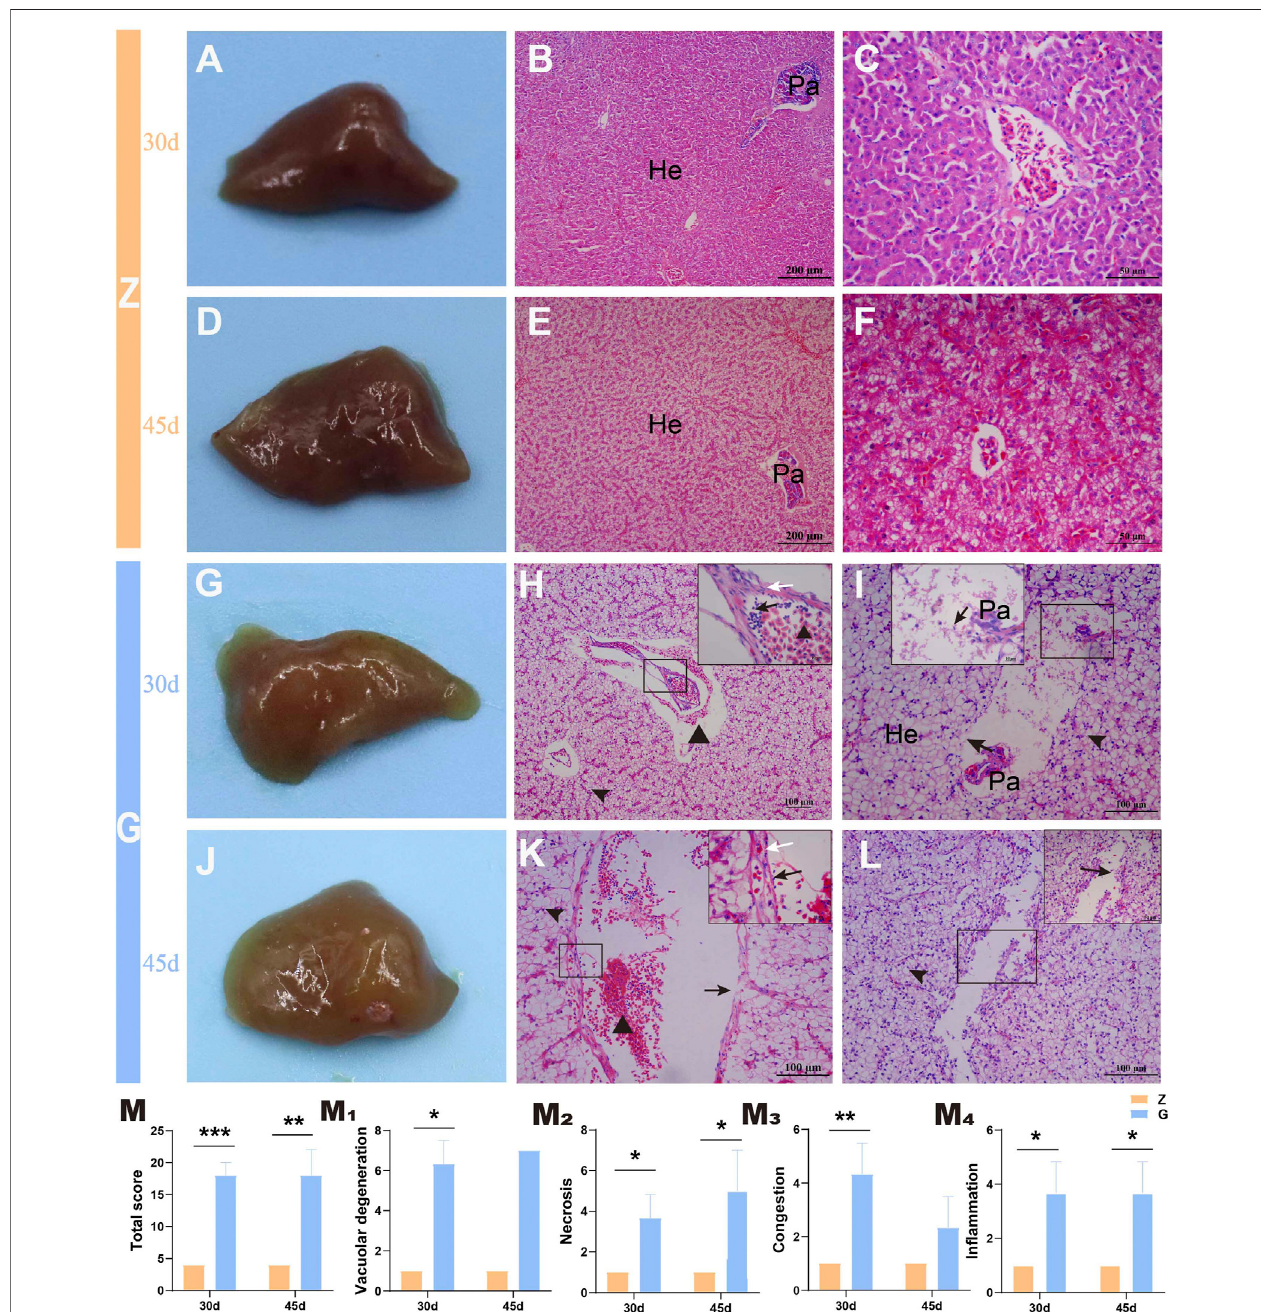
FIGURE2| Grosspathologyandhistopathologicalobservationsofthelargemouthbassliver(H&Estaining). (A – C) and (D – F) TheliveroflargemouthbassfedZdiet at 30 and 45 days, respectively. (A , D) The livers of largemouth bass fed Z diet were ruddy. (B,C) and (E,F) Hepatocyte morphology with no obvious morphological changes. (G – I) and (J – L) The liver of largemouth bass fed G diet at 30 and 45 days, respectively. (G , J) The livers of largemouth bass fed Z diet were visibly white. (H , K) Severe vacuolation of hepatocytes (arrowhead), congestion of the hepatic sinusoids (triangle), thickening of the vascular endothelium (white arrow), and accompanying in fl ammatory cell in fi ltration (black arrow). (I , L) Vascular endothelial cell and hepatocyte necrosis, pancreatic atrophy, and pancreatic cell necrosis and detachment (black arrow). (M) Total liver histopathological score. (M 1 – M 4 ) The histopathological scores for vacuolar degeneration, necrosis, congestion, and in fl ammation, respectively. He, hepatocytes; Pa, pancreas (* p < 0.05, ** p < 0.01, and *** p < 0.001).